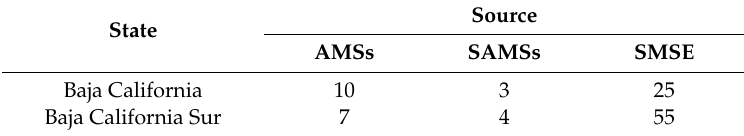
Table 1. Number of meteorological stations and SMSE points along the Baja California Peninsula.